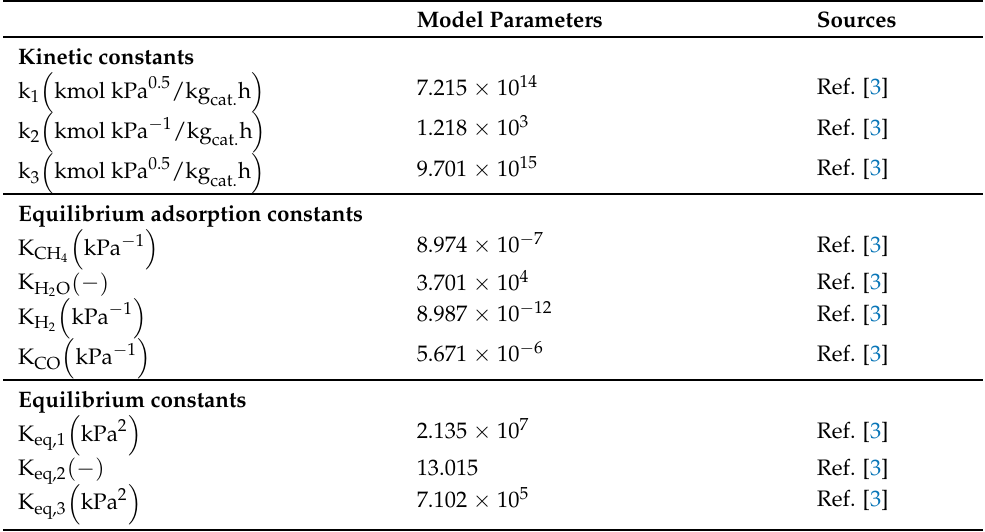
Table 3. Numeric values of kinetic constants, adsorption constants, and equilibrium constants for simulating of the SRM method on PBMR.